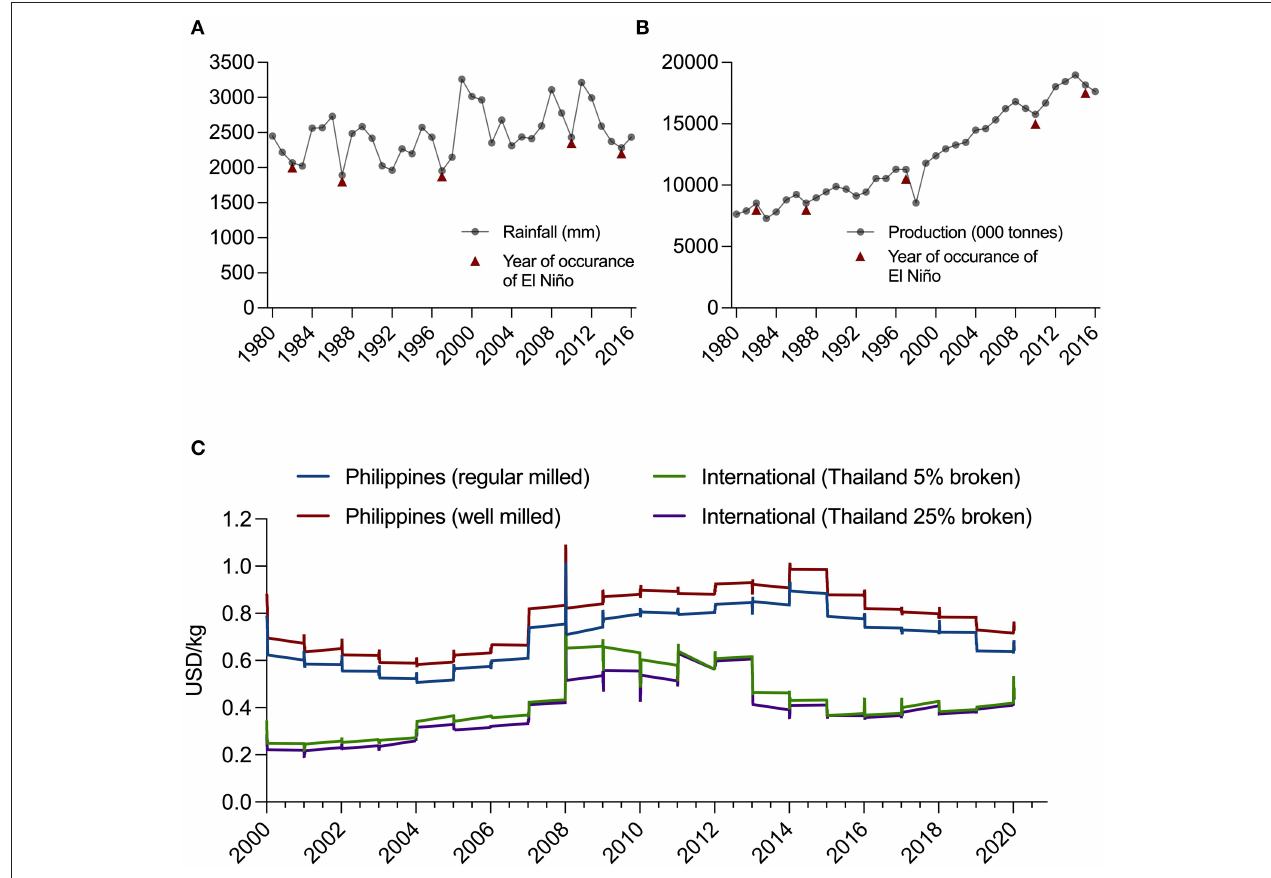
FIGURE 2 | Potential drivers of various AWD initiatives in Philippines including (A) rainfall and El Niño cycles, (B) total rice production, and (C) rice price (Sources: World Bank, 2021; FAO STAT; FAO GIEWS FPMA; IMF-IFS; OCHA, 2015).